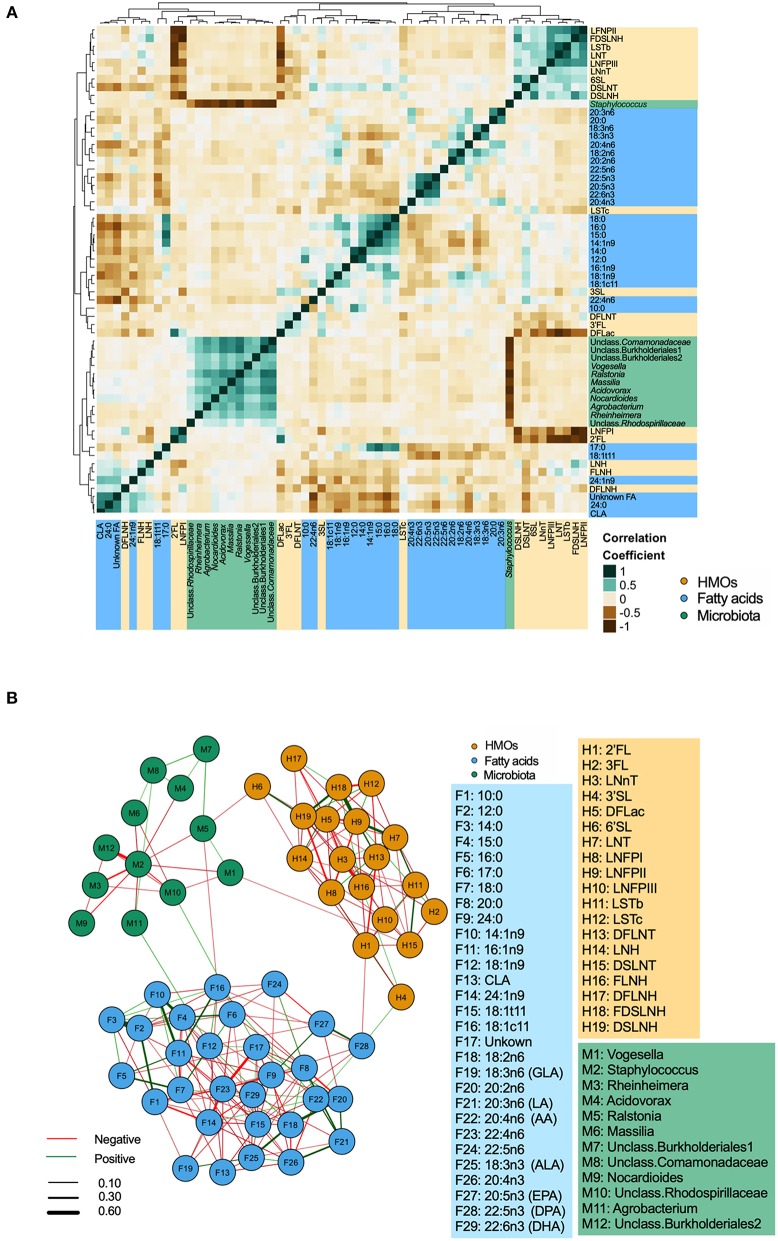
Inter and intra-correlations of milk microbiota, human milk oligosaccharides (HMOs), and fatty acids. (A) Clustering heatmap based on Spearman rank correlation, (B) Network visualization based on partial Spearman rank correlations. Line color represents the direction of correlation: green (positive), red (negative). Line width is proportional to the correlation coefficient.